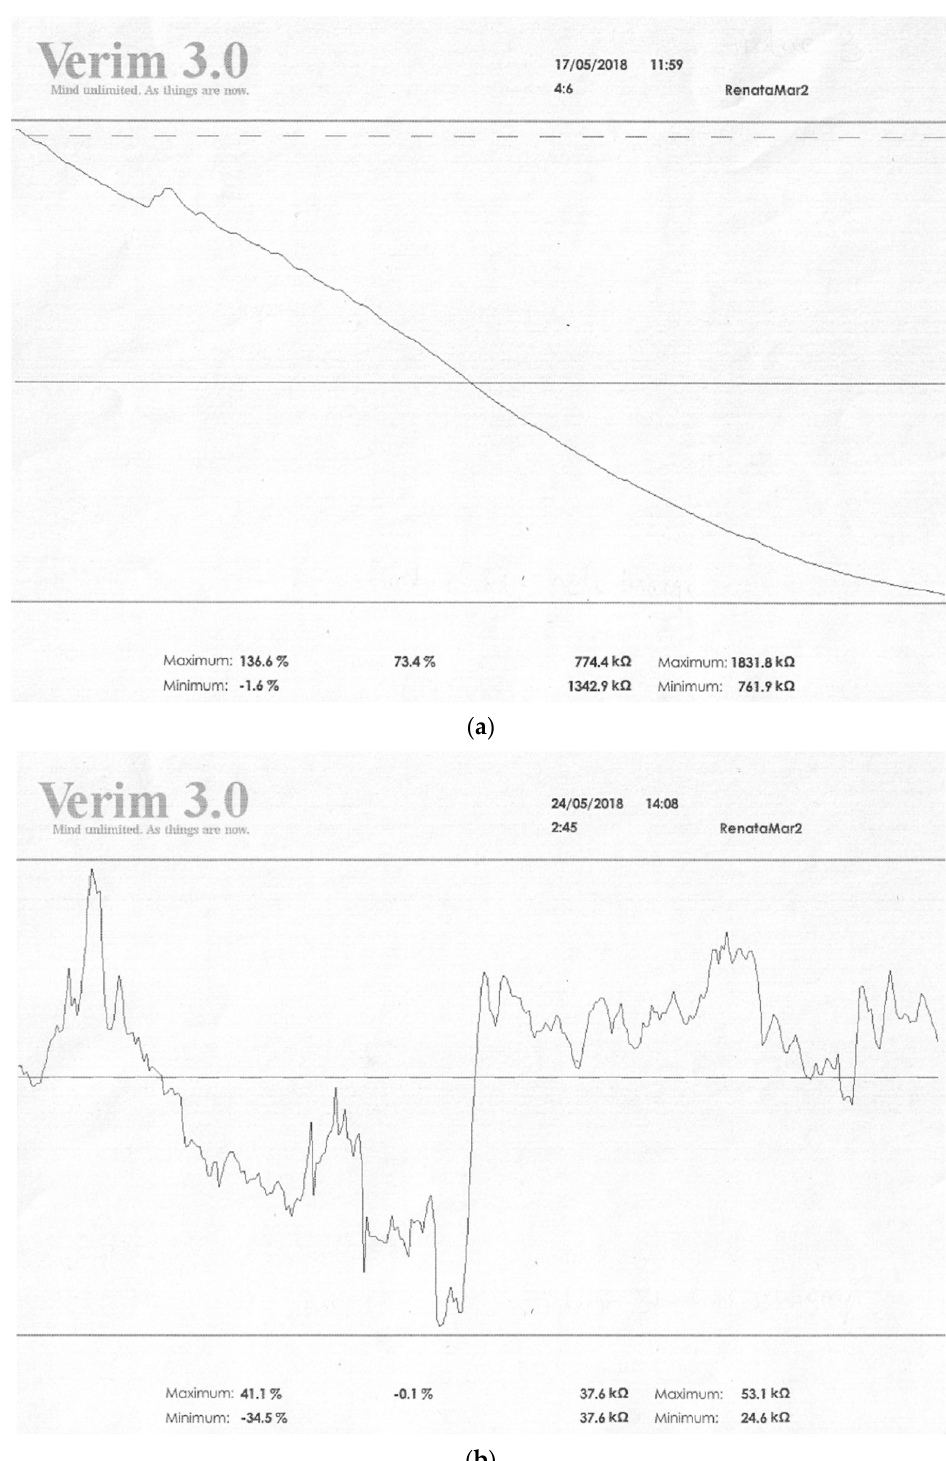
Figure 3. ( a ) Figure showing the state of relaxation. ( b ). Figure showing the state of non-relaxation. Legend: max vs. min—values of resistance achieved by the patient in kOhm; values on the right refer to relaxation, on the left to activation. Higher values in relaxation training indicate an increase in resistance and thus an increase in relaxation; low values indicate a decrease in resistance, an increase in conductivity, and thus a decrease in relaxation. The values on the left side are the activation level. If relaxation increases, the activation of the organism decreases. Five max values vs. min are the results analogous to those presented in